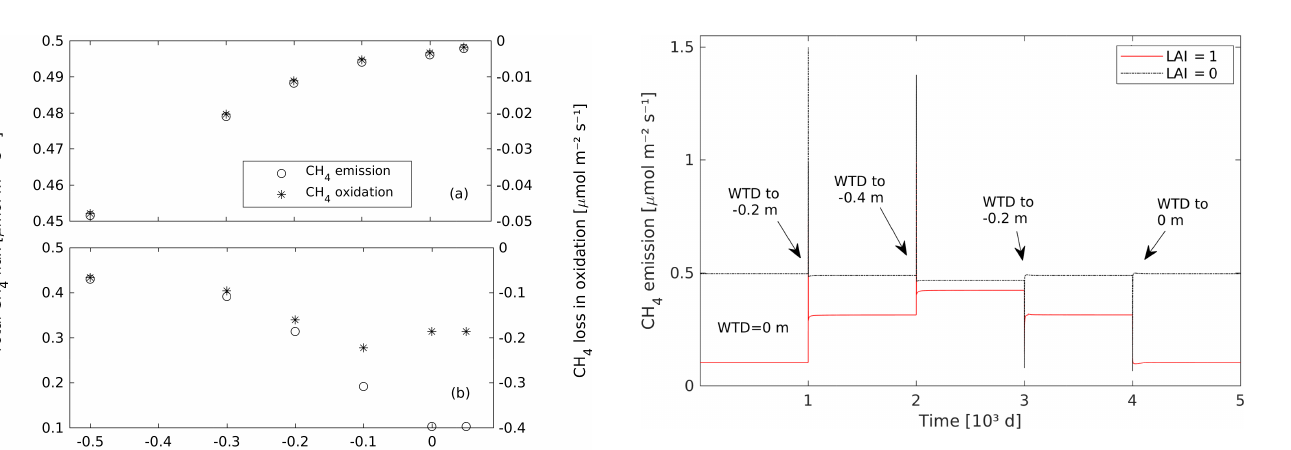
Figure 10. Effect of abrupt changes in WTD on the total output CH 4 emissions in transition tests Wtr_L0 (dashed line) and Wtr_L1 (solid line). Black arrows indicate the change in WTD. This figure also shows how changes in the WTD cause a short peak in the flux, because of how the CH 4 (and CO 2 and O 2 ) in layers receiving or losing water is handled in the model (see Sect.